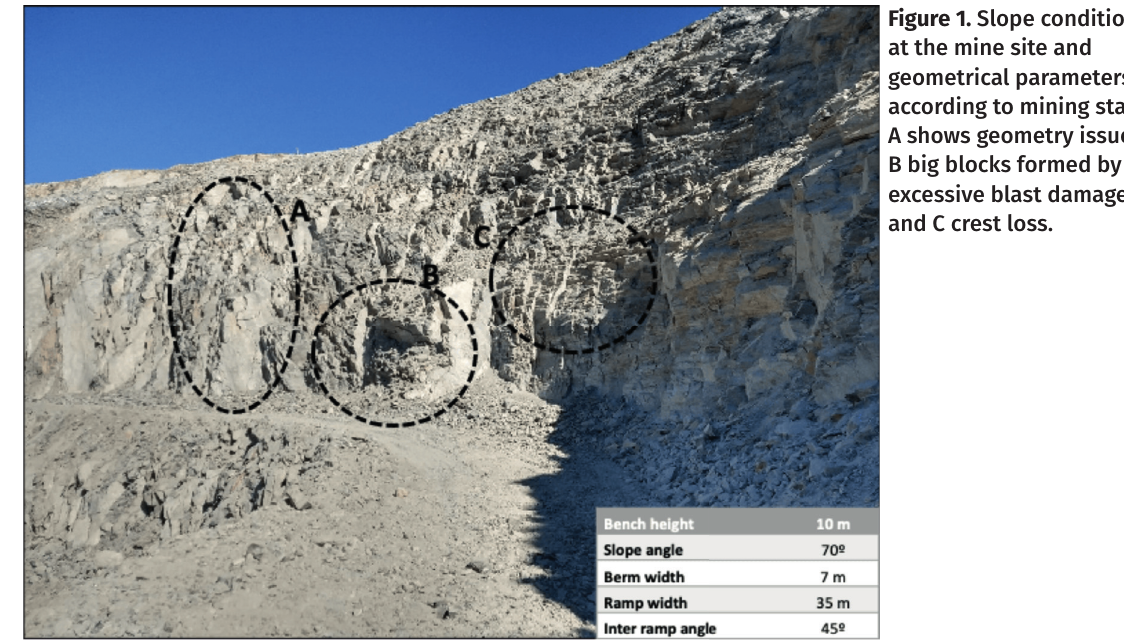
Figure 1. Slope conditions at the mine site and geometrical parameters according to mining